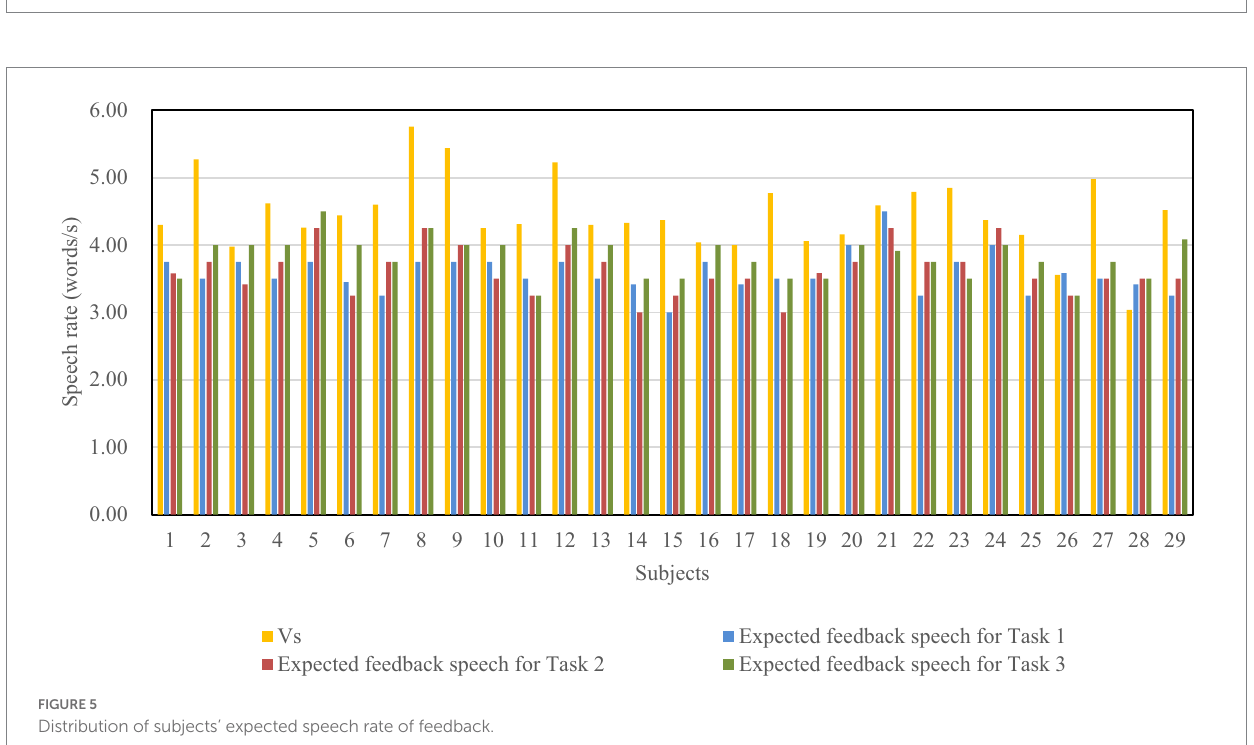
FIGURE 5 Distribution of subjects’ expected speech rate of